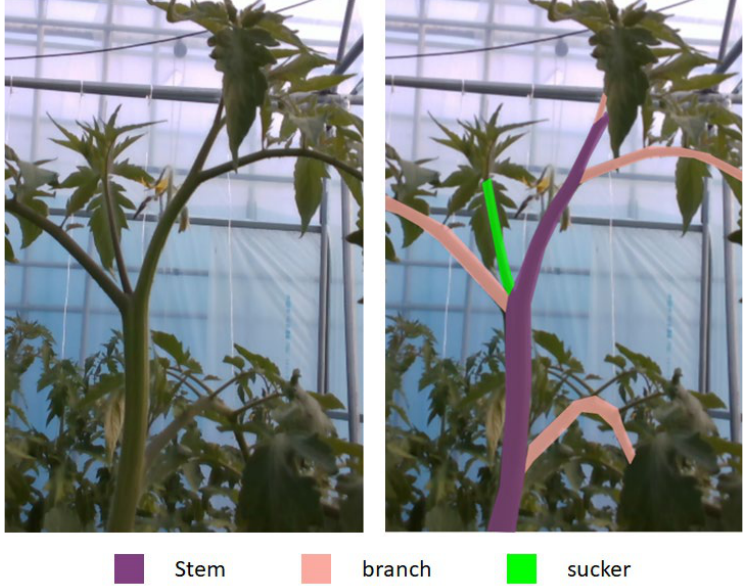
Figure 1. Tomato plant parts. A stem is a part that has nodes from that suckers, leaves, and flowers grow out. The first stem forms the main axis of the plant. A tomato plant should have one to three stems. We call a compound leaf which only has small leaves a branch. A sucker rises at a node of a stem. It is always between a stem and a branch. If the sucker is not removed and is old enough, it becomes a stem.